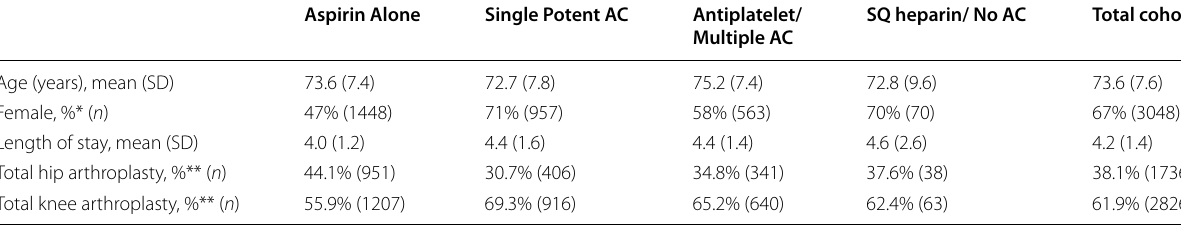
Table 1 Comparison of demographics and length of stay between anticoagulant groups Aspirin Alone Single Potent AC Antiplatelet/ SQ heparin/ No Multiple AC